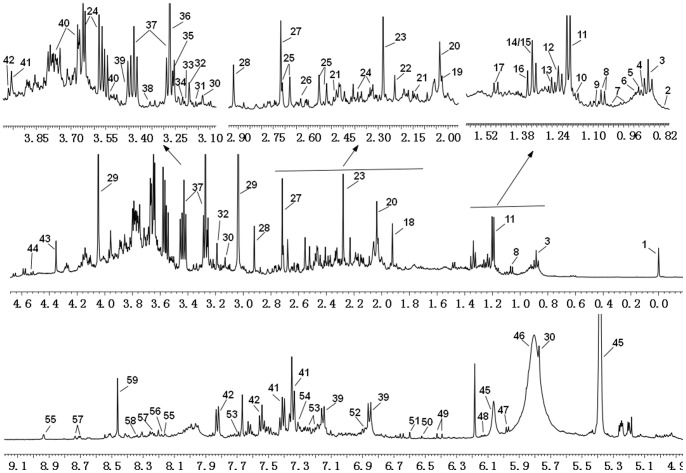
500 MHz 1H NMR spectra of urine samples.1, DSS; 2, 2-Hydroxyisovalerate; 3, 2-Hydroxybutyrate; 4, 2-Hydroxyvalerate; 5, 2-Oxoglutarate; 6, Isoleucine; 7, Valine;8, Isobutyrate; 9, Methylsuccinate; 10, Ethanol; 11, 3-Hydroxybutyrate; 12, Fucose; 13, 3-Hydroxyisovalerate; 14, Lactate; 15, 3-Hydroxy-3-methylglutarate; 16, 2-Hydroxyisobutyrate; 17, Alanine; 18, Acetate; 19, N-Acetylglutamate; 20, N-Acetylglycine; 21, Glutamine; 22, Acetone; 23, Acetoacetate; 24, Glycerol; 25, Citrate; 26, Methylamine; 27, Dimethylamine; 28, N,N-Dimethylglycine; 29, Creatinine; 30, cis-Aconitate; 31, O-Acetylcarnitine; 32, Choline; 33, O-Phosphocholine; 34, Carnitine; 35, Betaine; 36, Trimethylamine N-oxide; 37, Taurine; 38, Methanol; 39, 4-Hydroxyphenylactate; 40, 3-Methylxanthine; 41, N-Phenylacetylglycine; 42, Hippurate; 43, Tartrate; 44, Xylose; 45, Allantoin; 46, Urea; 47, Cytosine; 48, ADP; 49, Urocanate; 50, Fumarate; 51, trans-Aconitate; 52, Tyrosine; 53, 3-Indoxylsulfate; 54, 3-Phenyllactate; 55, Nicotinamide N-oxide; 56, Hypoxanthine; 57, Nicotinurate; 58, Inosine; 59, Formate.